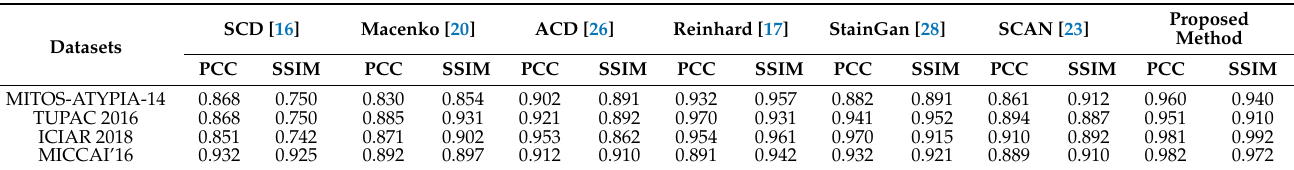
Table 2. Comparison of PCC and SSIM for different color normalization